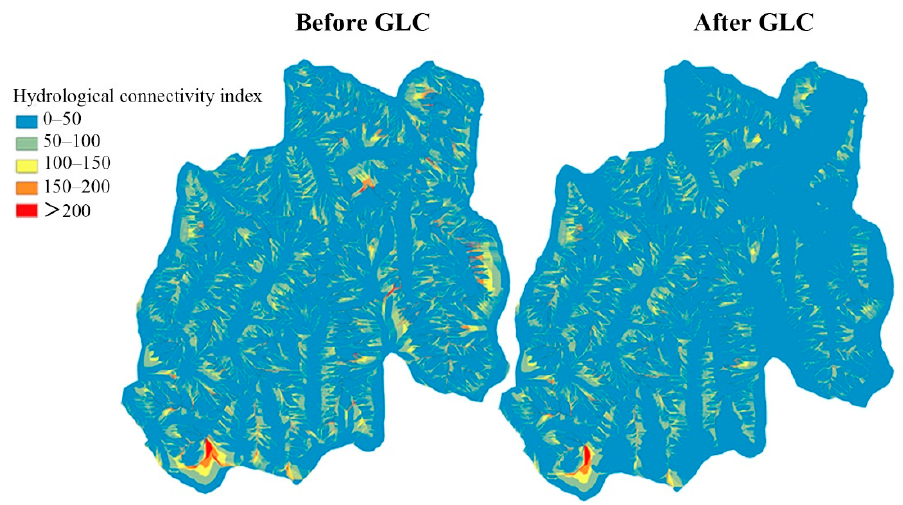
Figure 12. Hydrological connectivity of Xingshuyaozi watershed before GLC (in 2013) and after GLC (in 2019).